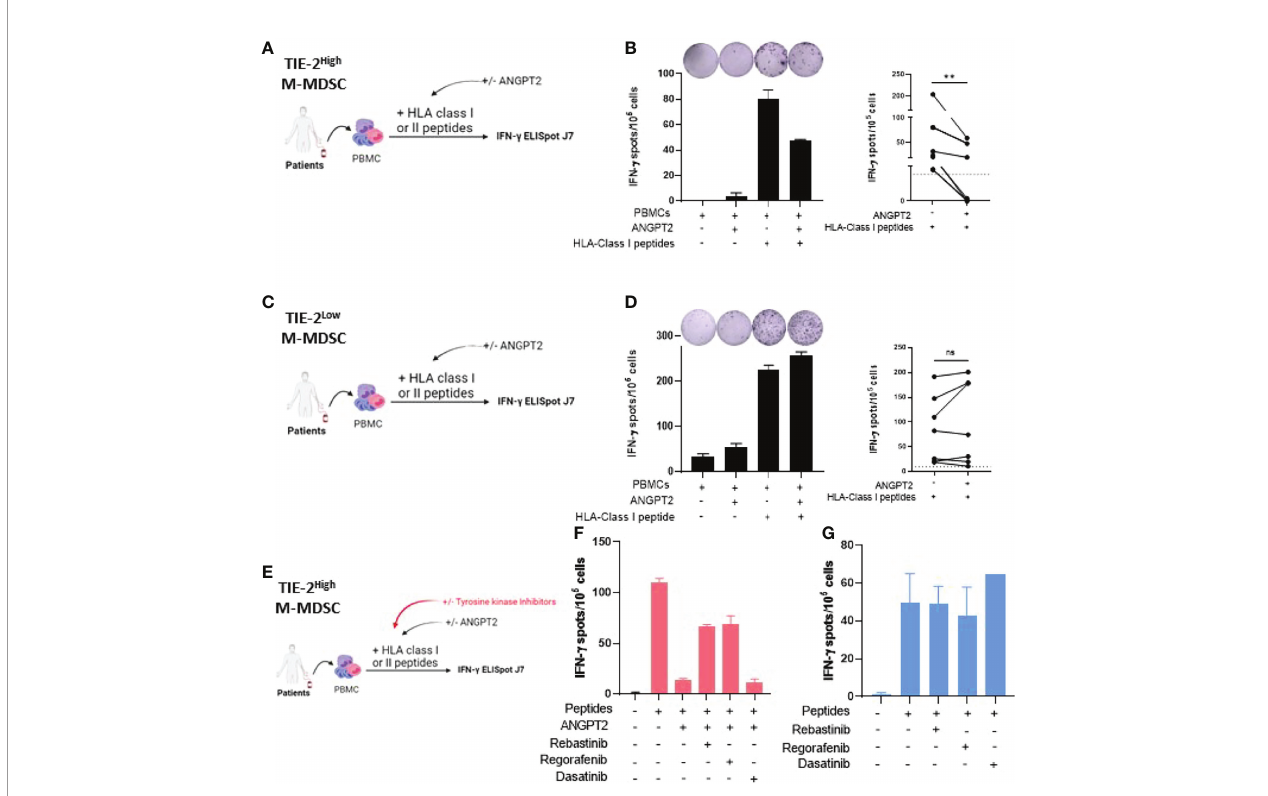
FIGURE 4 | Effect of ANGPT2/TIE-2 signaling on M-MDSC on antitumor responses. (A) Peripheral blood mononuclear cells (PBMCs) from melanoma patients with TIE-2 high M-MDSC were stimulated with TERT class I peptides in presence or not of 300 ng/ml of ANGPT2, and an IFN- g ELISpot assay was performed. (B) Left, IFN- g T-cell responses of one representative example of patient; right, histograms from 6 patients (Wilcoxon test, **p < 0.01). (C) PBMCs from melanoma patients with TIE-2 low M-MDSC were stimulated with TERT class I peptides in presence or not of 300 ng/ml of ANGPT2, and an IFN- g ELISpot assay was performed. (D) Left, IFN- g T-cell responses of one representative example of patient; right, histograms from 8 patients (Wilcoxon test, **p < 0.01). (E) PBMCs from melanoma patients with TIE-2 high M-MDSC were stimulated with TERT class I or class II peptides in presence or not of ANGPT2 and in presence or not of TIE-2 inhibitors, and then an IFN- g ELISpot was performed. (F) Histograms of IFN- g T-cell responses in presence of ANGPT2 (n = 6). (G) Histograms of IFN- g T-cell responses in the absence of ANGPT2 (n = 6). ns, no signigicant.